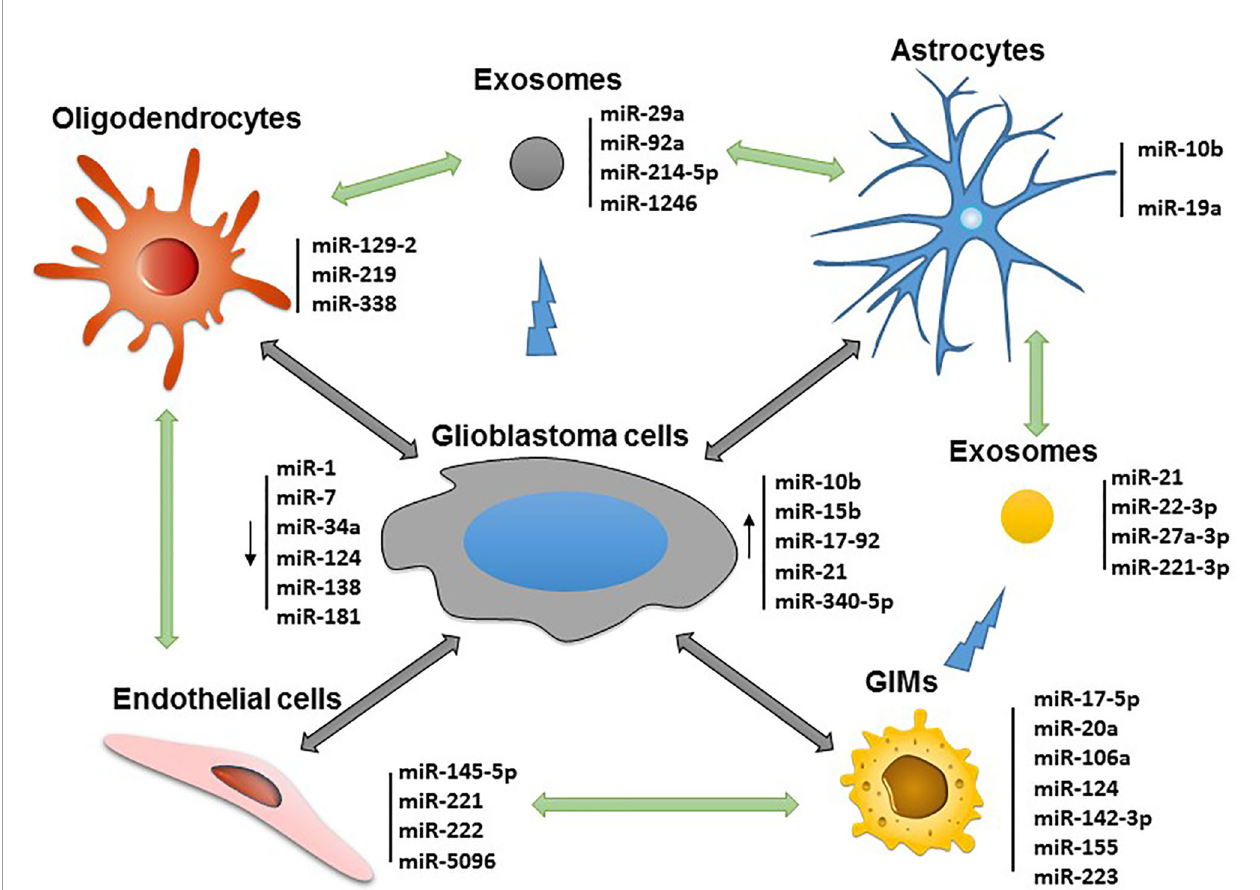
FIGURE 1 | Potential miRNAs that can be targeted for immune modulation and therapeutic application in the glioblastoma